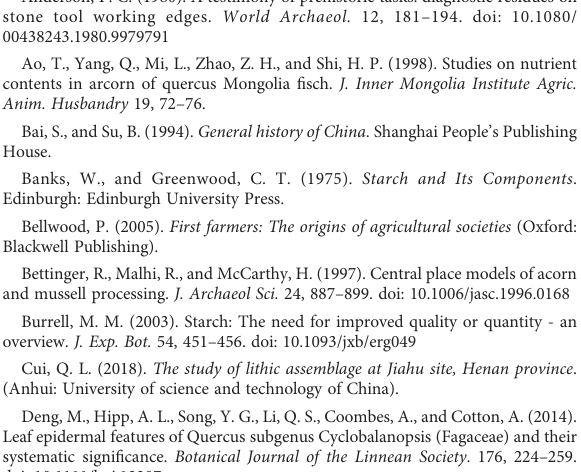
SUPPLEMENTARY TABLE 1 Plant materials used in this study and their collection information. SUPPLEMENTARY TABLE 2 Dichotomous key for starch granule of